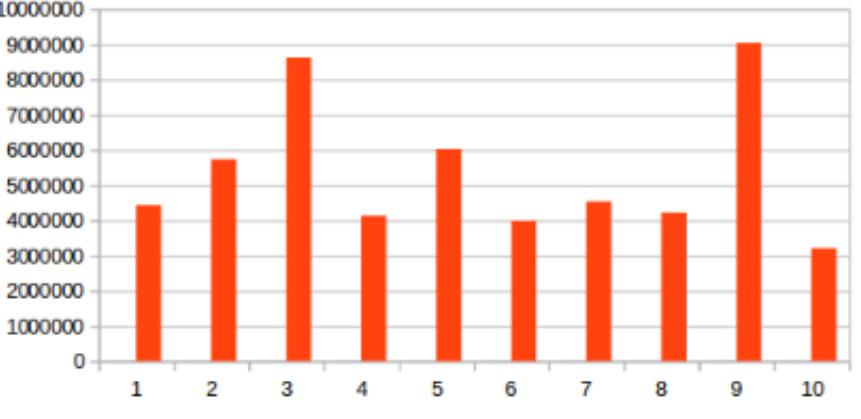
Figure 2. Skewed key frequencies